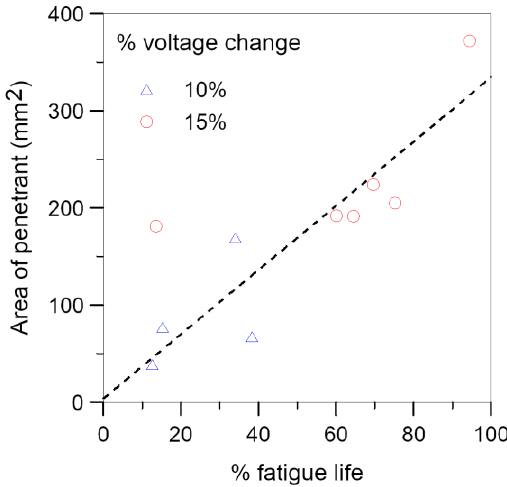
Figure 16. De-bonded area at different percentages of fatigue life.